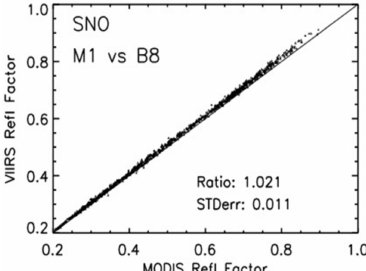
Figure 2. Example of pixel-to-pixel comparison of reflectance between SNPP VIIRS M1 and Aqua MODIS band 8 obtained from one SNO event at 21:48 GMT on 7 October 2021. The pixel matchup is determined from the center-to-center distance (<350 m) between VIIRS and MODIS. Numbers shown in the figure are values of the averaged VIIRS to MODIS reflectance ratio and standard